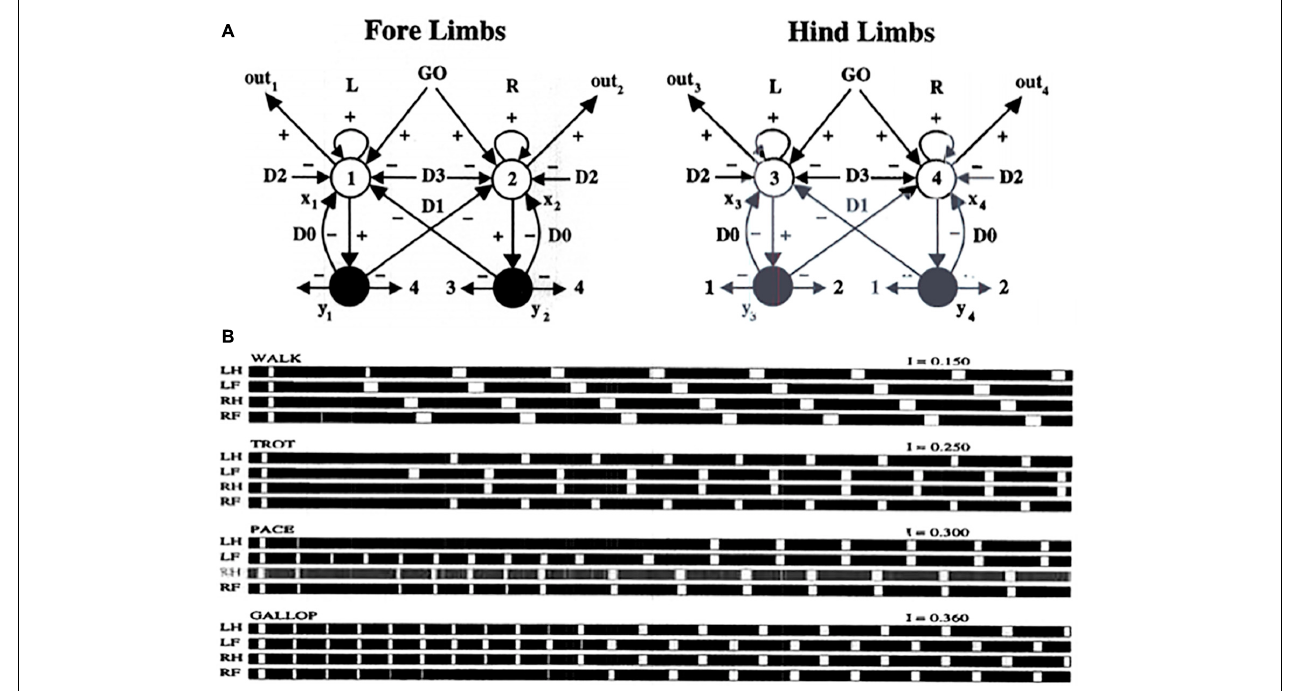
FIGURE 15 | A pair of interacting recurrent shunting on-center (+ signs) off-surround (– signs) networks model the central pattern generator, or CPG, that controls quadruped movement gaits. Movement gait transitions are activated by an increasing volitional GO signal. Cells that emit excitatory signals are denoted by open circles. Inhibitory interneurons that emit inhibitory signals are denoted by closed disks. (A) Self-inhibitory feedback is labeled by the parameter D0, inhibition between forelimbs and between hindlimbs is labeled by D1, inhibition between matched forelimbs and hindlimbs is labeled by D2, and inhibition between crossed forelimbs and hindlimbs is labeled by D3. (B) Computer simulation of how increasing the GO signal, when it is combined with GO signal modulation of the inhibitory coefficients, triggers an ordered series of gaits (walk, trot, pace, and gallop). [Reprinted with permission from Pribe et al.